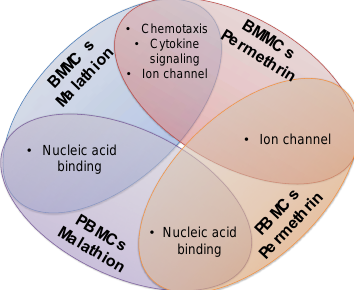
Figure 4. Common cellular functions altered by modification in gene expression in BMMCs and PBMCs exposed to insecticides. Results derived from over-representation test analyzing the total of genes with gene expression changes determined by Panther Pathways program.